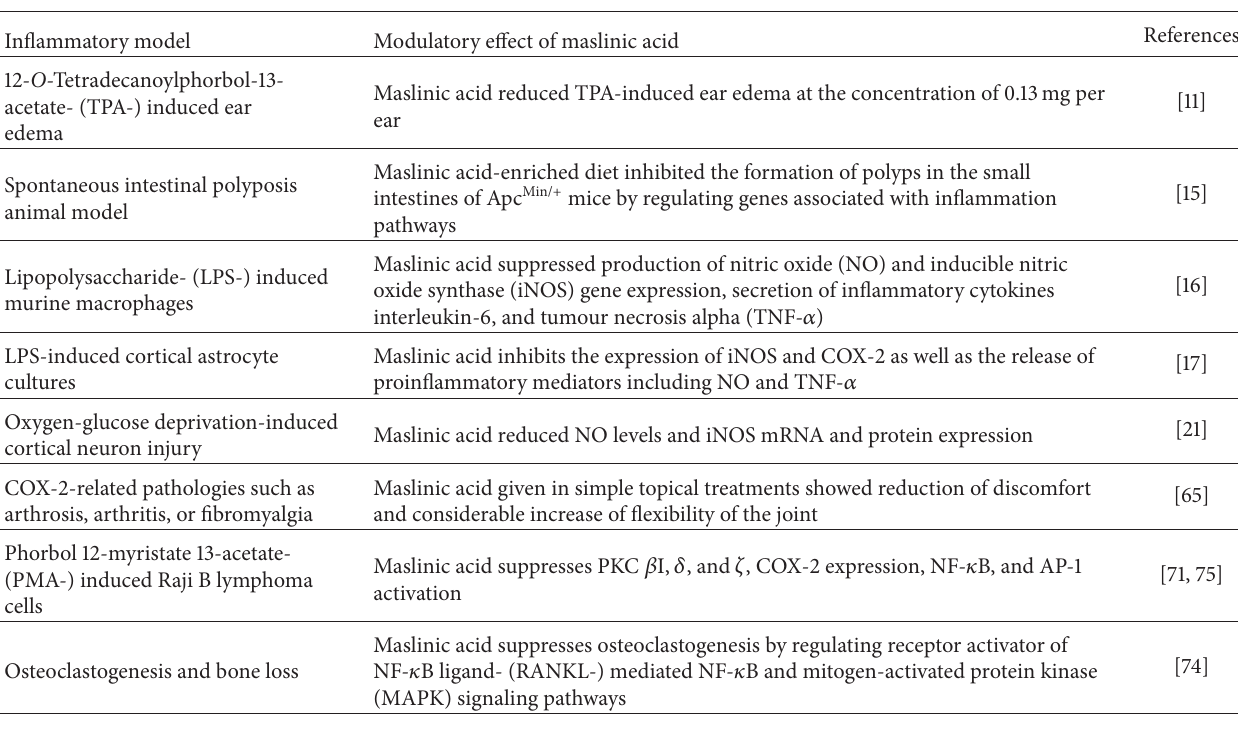
Table 1: Inflammatory modulating effect of maslinic acid.